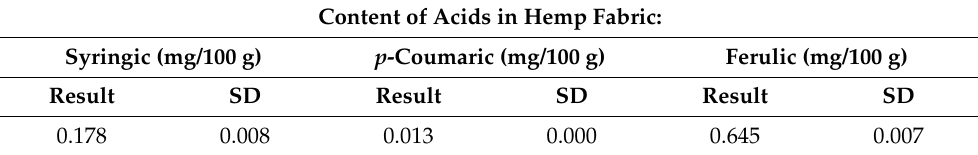
Table 5. Phenolic acids content in a pure hemp fabric.